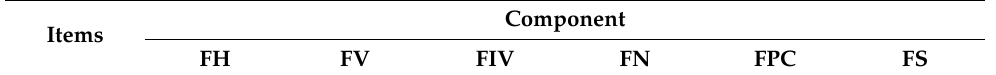
Table 6. Standardized Regression Weights from Confirmatory Factor